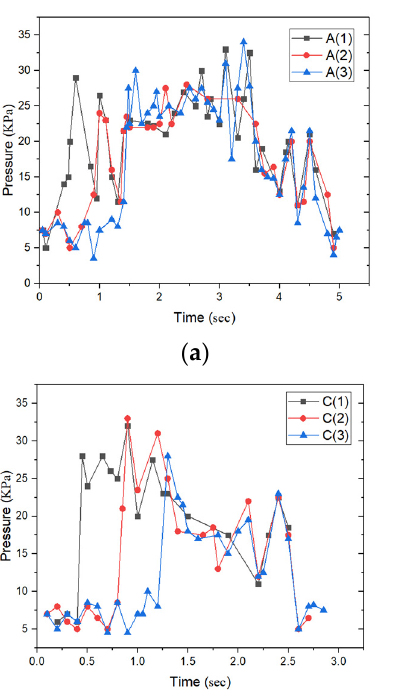
Figure 28 . Pressure of the di ff erent numbers of cups at the A, B, C and D monitoring points: ( a )